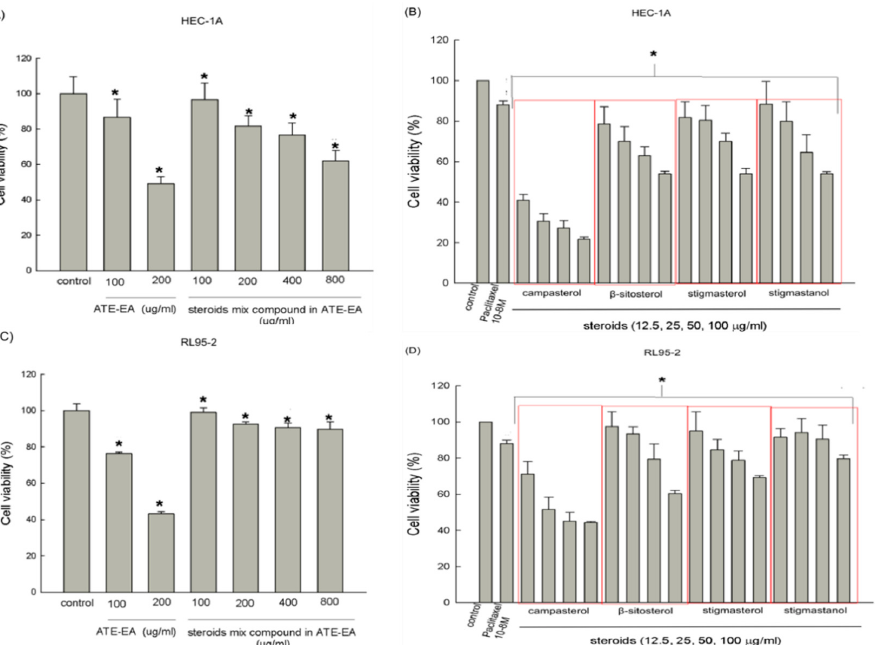
Figure 4. Effects of steroid compounds from ATE-EA on the viability of HEC-1A and RL95-2 cells. HEC-1A cells were treated with serial concentrations of steroid compounds ( A ) and the constituents ( B ) of ATE-EA for 48 h. RL95-2 cells were treated with serial concentrations of steroid compounds ( C ) and the constituents ( D ) of ATE-EA for 48 h. Cell viability was detected using an MTT assay. Data are expressed as means ± SD ( n = 3). * p < 0.05, p < 0.01, compared with the control group at the basal level. ATE-EA, ethyl acetate fraction of the adlay testa ethanolic